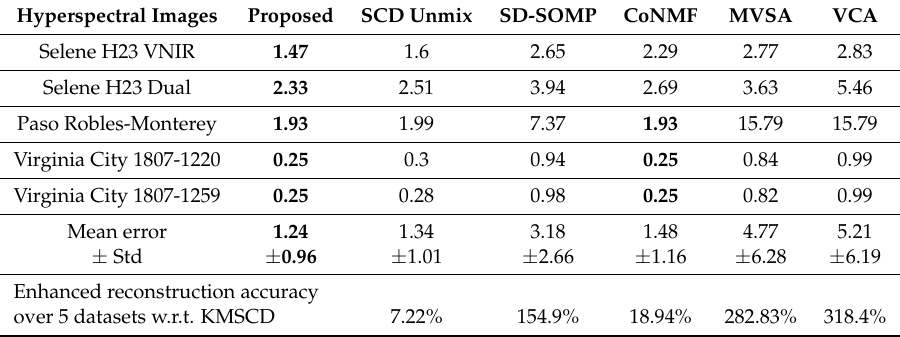
Table 3. Mean Manhattan distance error on various hyperspectral scenes.